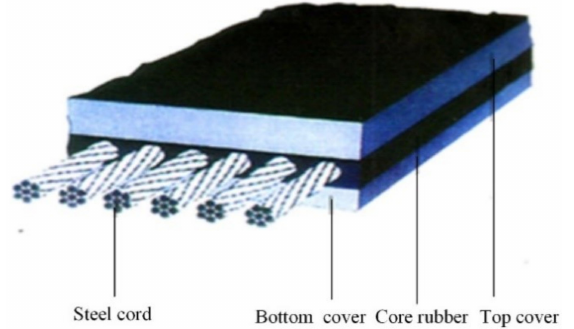
Figure 1. The structure of the steel cord conveyor belt.